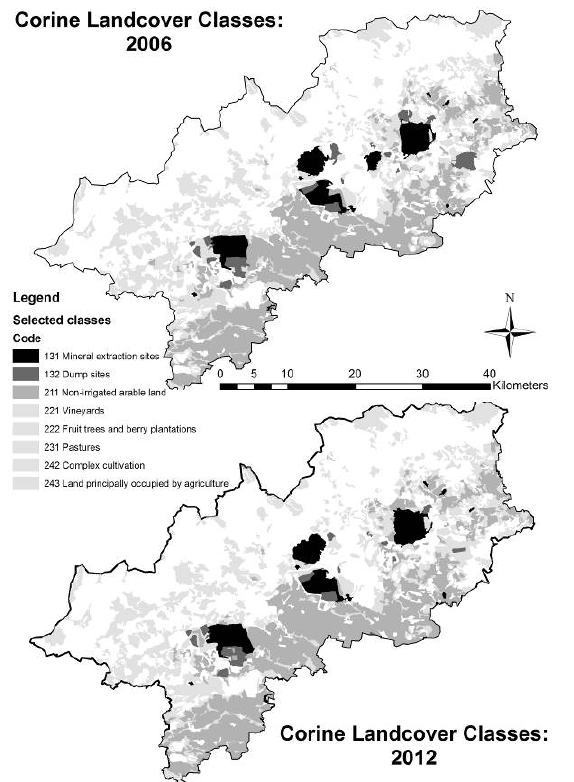
Figure 7. Mapping of weirs for utilization of small hydro energy plants, and population in the regional